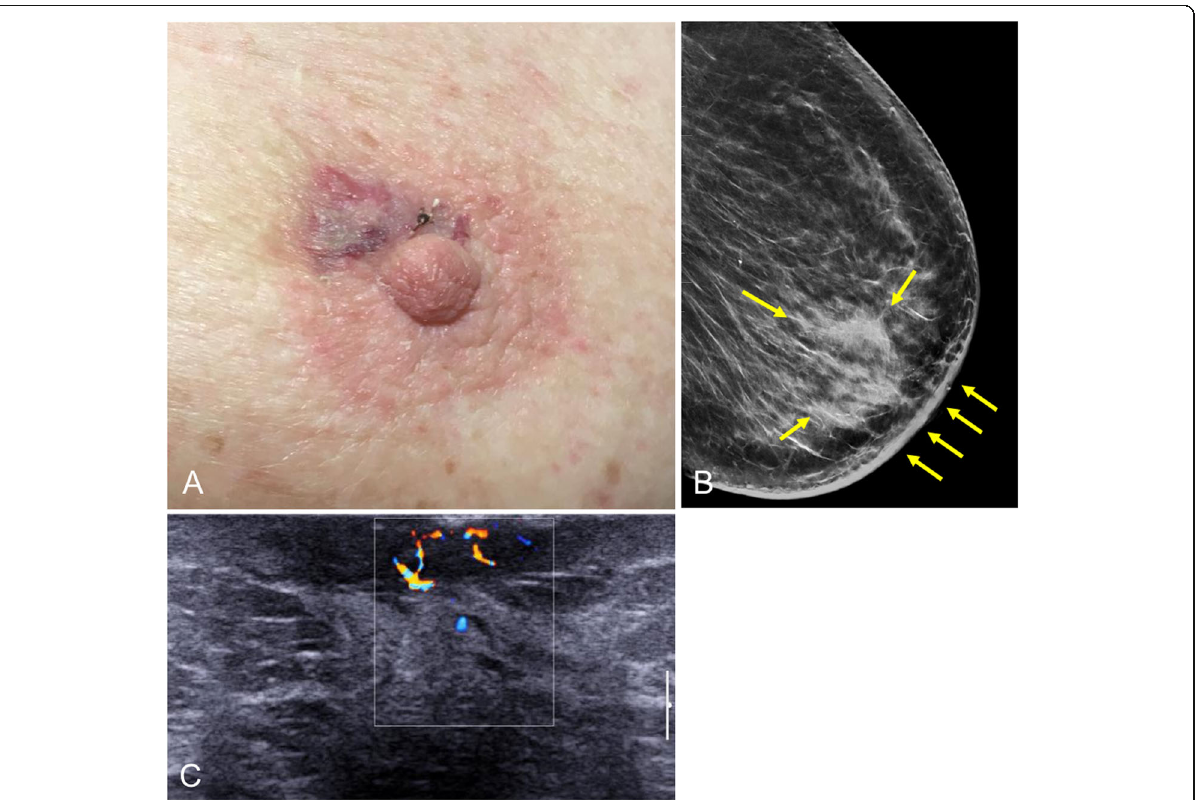
Fig. 37 Radiation-associated angiosarcoma. A 76-year-old woman with a history of breast cancer treated with conservative surgery and whole-breast radiation therapy 6 years prior. a Photograph shows an ill-defined erythematous-violaceous infiltrated plaque with an eroded area occupying part of the areola. b Synthesized 2D mammogram shows skin thickening and interstitial edema in the retroareolar region of the left breast. c Ultrasound shows an ill-defined hypoechoic skin lesion with an internal Doppler signal. Punch biopsy diagnosed radiation-associated angiosarcoma, and the patient underwent